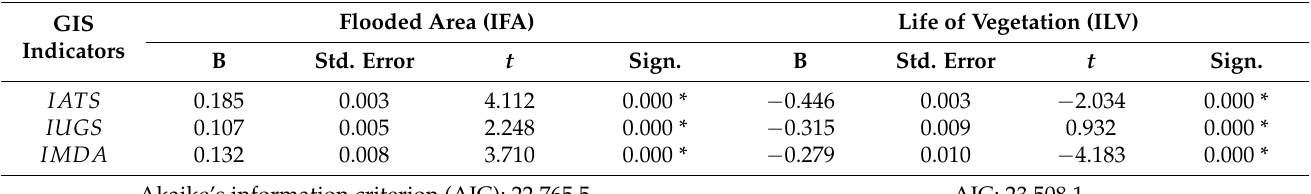
Table 4. Detailed multiple regression models (OLS) for LISA analysis of the different levels of spatial correlation between indicators for each of the three case studies. Doñana National